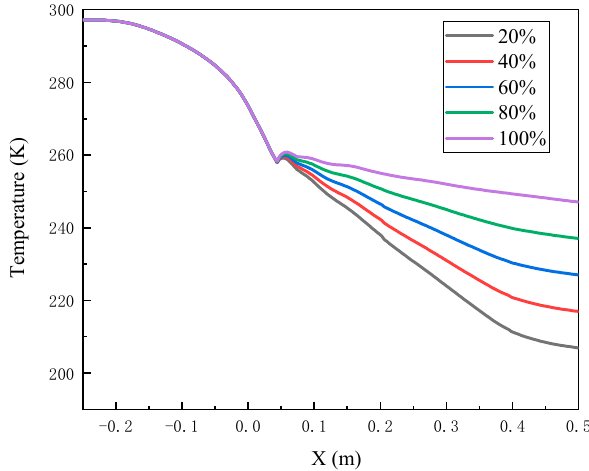
Figure 7. Temperature distribution along the Moore type “B” nozzle centerline for several relative air humidity levels.